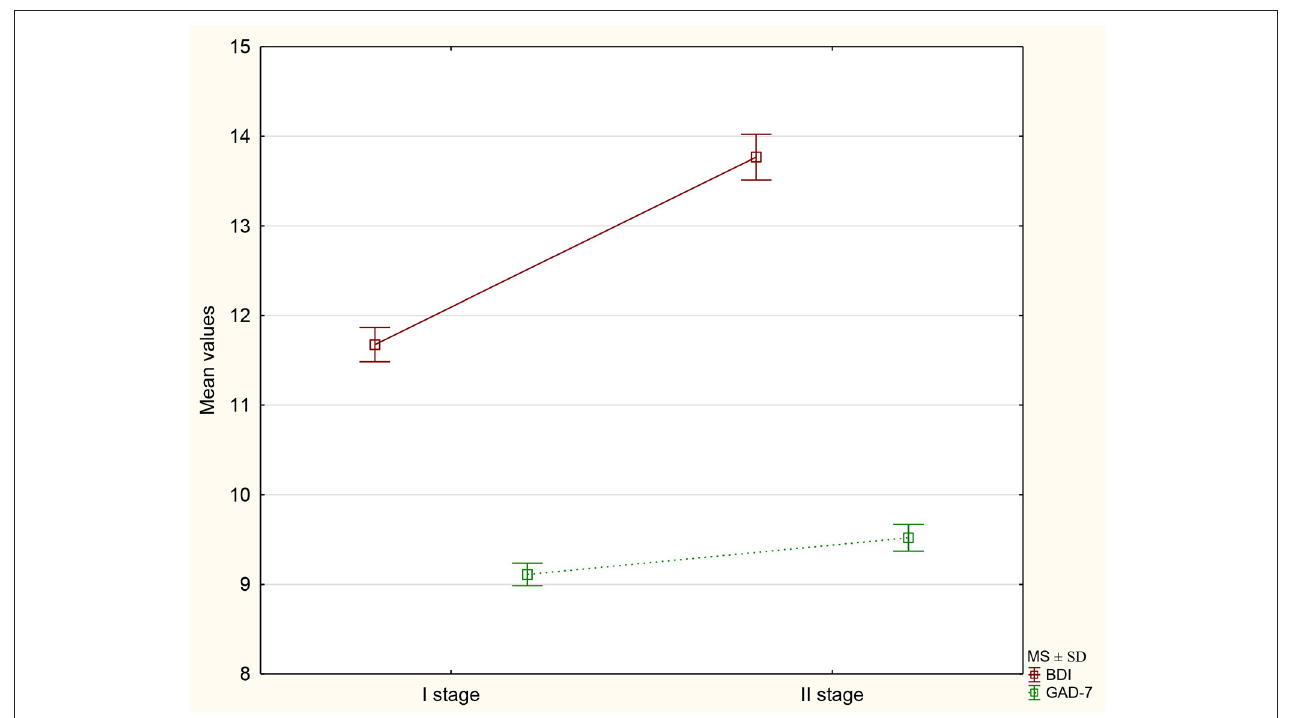
FIGURE 1 | The mean values ± standard deviation of the BDI and GAD-7 scores at both stages of the study.